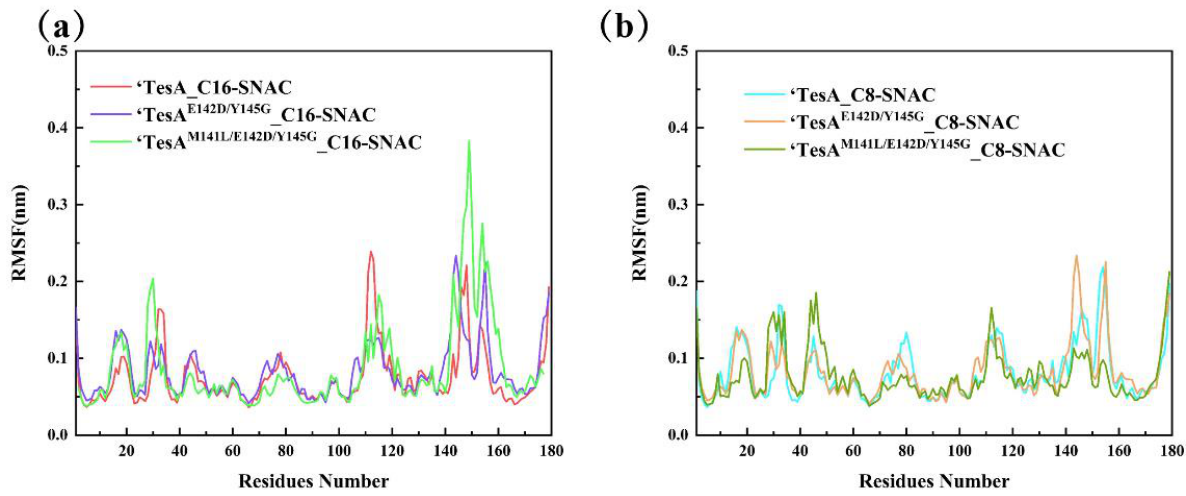
Figure 7. RMSF curves of the C α atoms of the six complexes during simulation. ( a ) RMSF curves of proteins in long-chain complexes, ( b ) RMSF curves of proteins in medium-chain complexes.